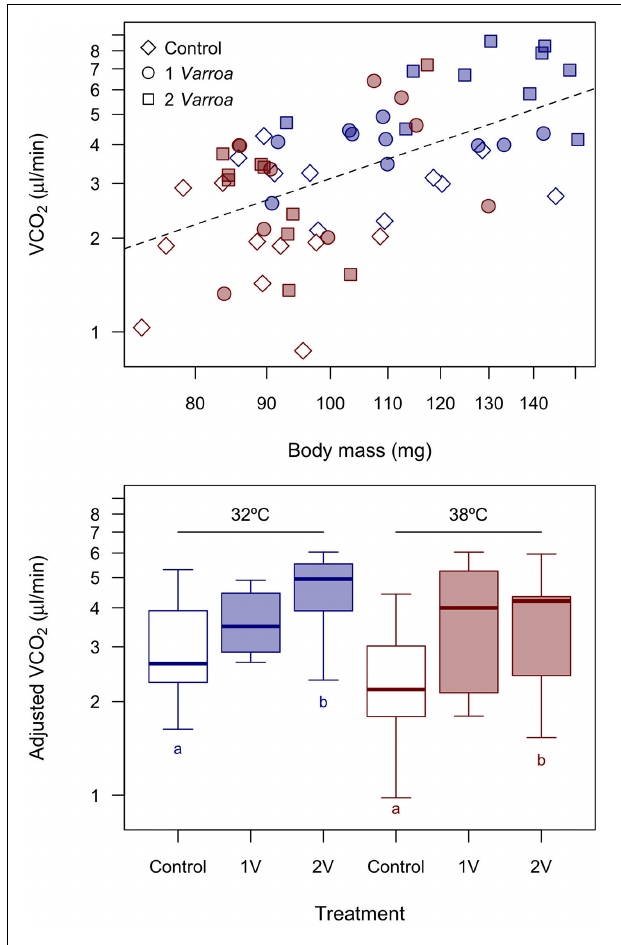
FIGURE 3 | Metabolic rates in honeybees acclimated to 32 and 38 ◦ C and exposed to different levels of parasitism by Varroa . For the boxplot adjusted estimates were calculated for a body mass of 103.5 mg. Symbols in the scatterplot as in Figure 2 . Pairwise differences between treatments employing Tukey contrasts (1-tailed p < 0.05) are shown with different letters (for simplicity we highlight only pairwise comparisons within acclimation groups, i.e., the effects of Varroa